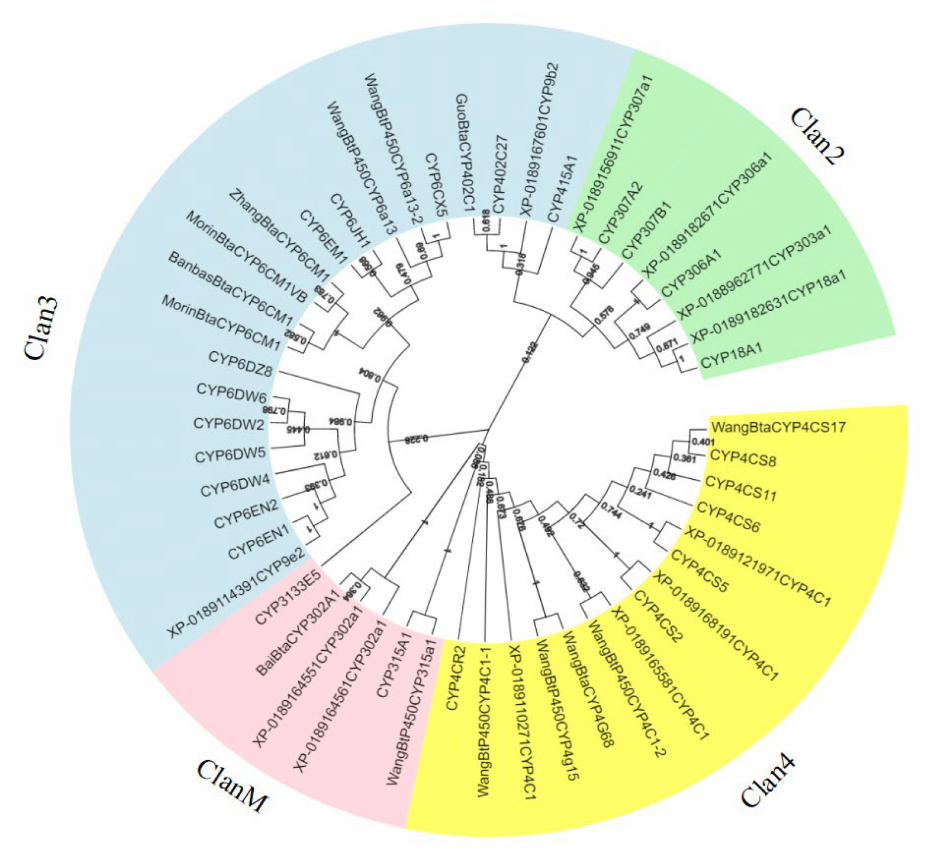
Figure 1. Phylogenetic relationships of P450 families from Bemisia tabaci MED. The unrooted phylo- gentic tree was constructed using MEGA7 by the neighbor-joining method. The bootstrap test was performed with 1000